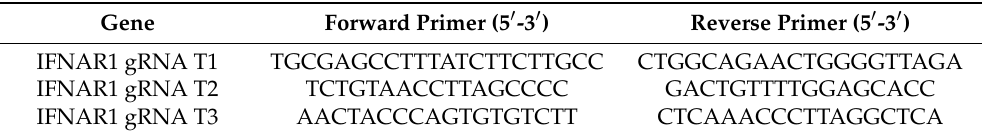
Table 2. List of primers used for Sanger sequencing. Gene Forward Primer (5 (cid:48) -3 (cid:48)